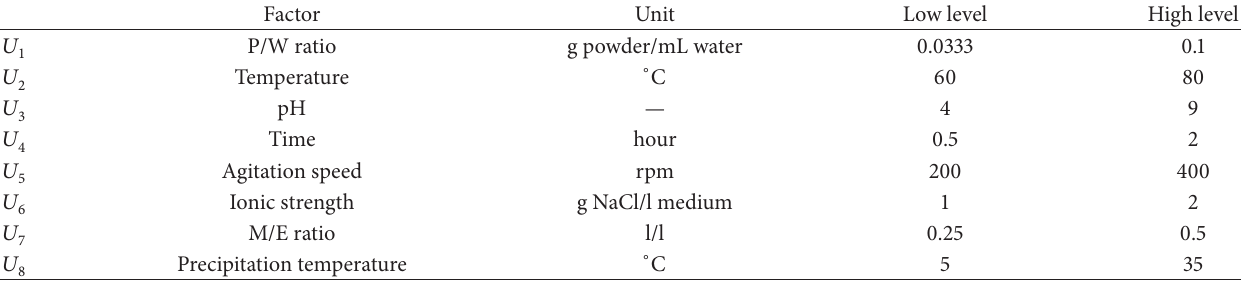
Table 1: Experimental domain for screening step.